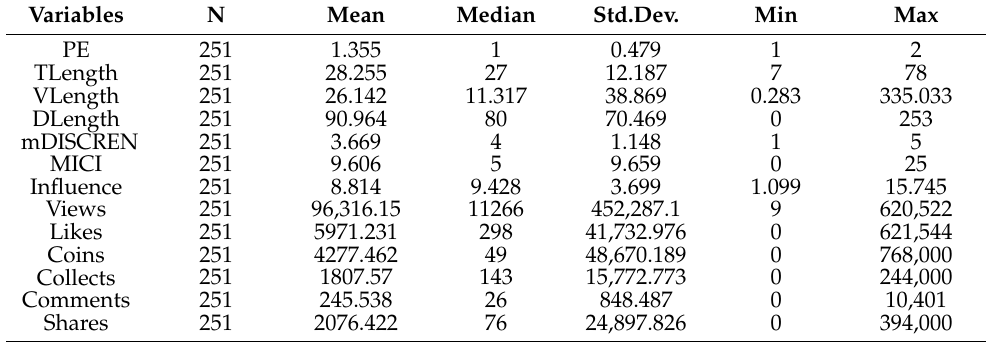
Table 5. Summary statistics.